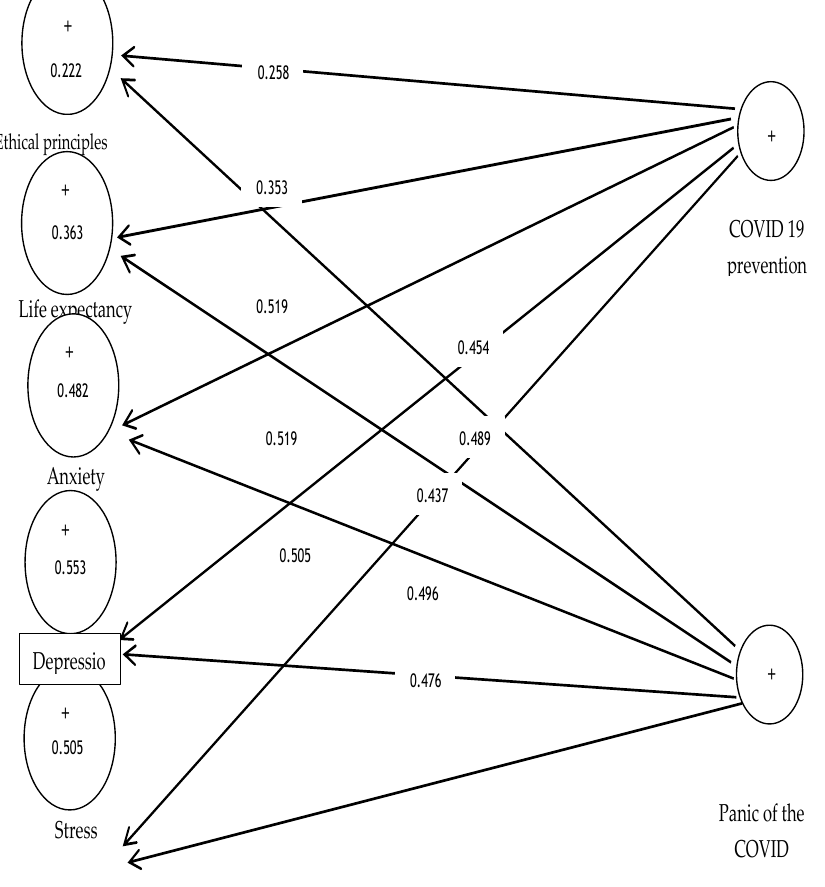
Figure 2. Factor load values.